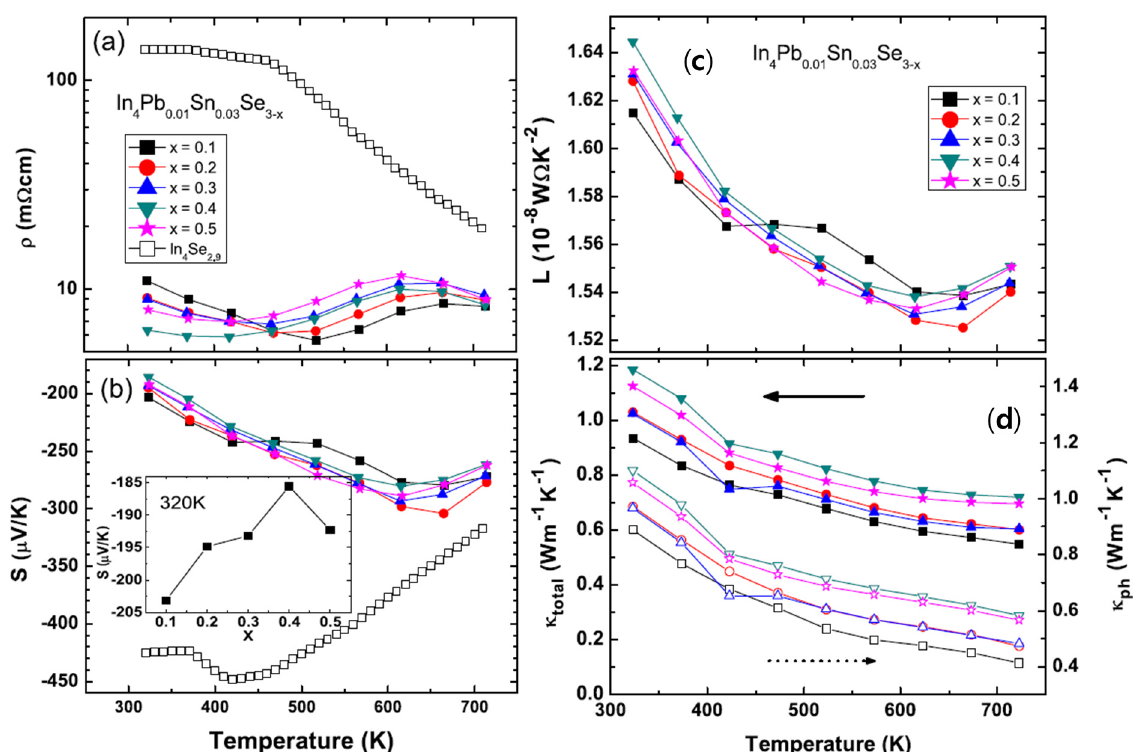
Figure 20. Temperature-dependent electrical resistivity ρ (T) ( a ), Seebeck coefficient S(T) ( b ), Temperature-dependent Lorenz number L ( c ), total thermal conductivity κ tot (closed symbols, left axis) and lattice thermal conductivity κ ph (open symbols, right axis) ( d ) of In 4 Pb 0.01 Sn 0.03 Se 3 − x ( x = 0.1, 0.2, 0.3, 0.4, and 0.5) polycrystalline compounds. Reproduced with permission from Elsevier B.V., 2014 [43].